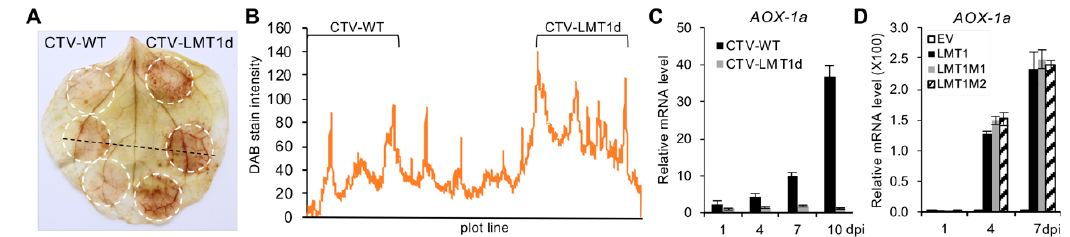
Figure 6. The effect of LMT1 on the accumulation of reactive oxygen species (ROS) and the expression of alternative oxidase ( AOX-1a ) gene. ( A ) ROS accumulation was demonstrated using 3,3’-diaminobenzidine (DAB) staining of the leaves infiltrated with CTV-WT or CTV-LMT1d. A representative image taken at 7 dpi is shown. The left and the right halves of the leaf were infiltrated with CTV-WT and CTV-LMT1d, respectively. A dotted black line is the plot was used for the quantification of staining intensity. ( B ) Relative DAB staining intensity measured from the image shown in ( A ). The value was determined by measuring the pixel intensity along the line plot. The infiltration spots are indicated by the brackets above the graph. ( C ) Relative mRNA levels of AOX-1a gene in the leaves infiltrated with CTV-WT and CTV-LMT1d at 1, 4, 7 and 10 dpi. Black bar, pCTV-WT; grey bar, pCTV-LMT1d. ( D ) Relative mRNA levels of AOX-1a gene in the leaves infiltrated with pLMT1 and its mutants at 1, 4 and 7 dpi. Open bar, “empty-vector” Agrobacterium control (EV); black bar, pLMT1; grey bar, pLMT1M1; bar filled with diagonal stripes, pLMT1M2. Each bar represents a mean value +/- standard error of the mean ( n = 3) within a set of samples consisting of one leaf disc per plant from three plants infiltrated with each treatment. For each set of repeats, three RT-qPCR determinations were made. Three repeat experiments showed similar results.